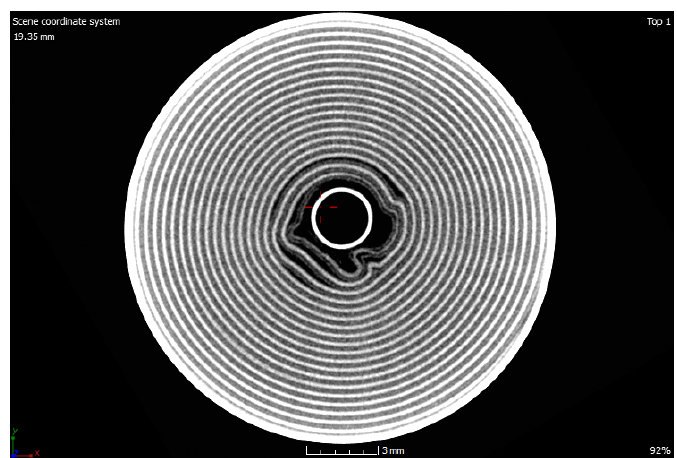
Figure 6. Top view CT scan of the cell 1p3. Structural changes of the jelly roll can be clearly identified.